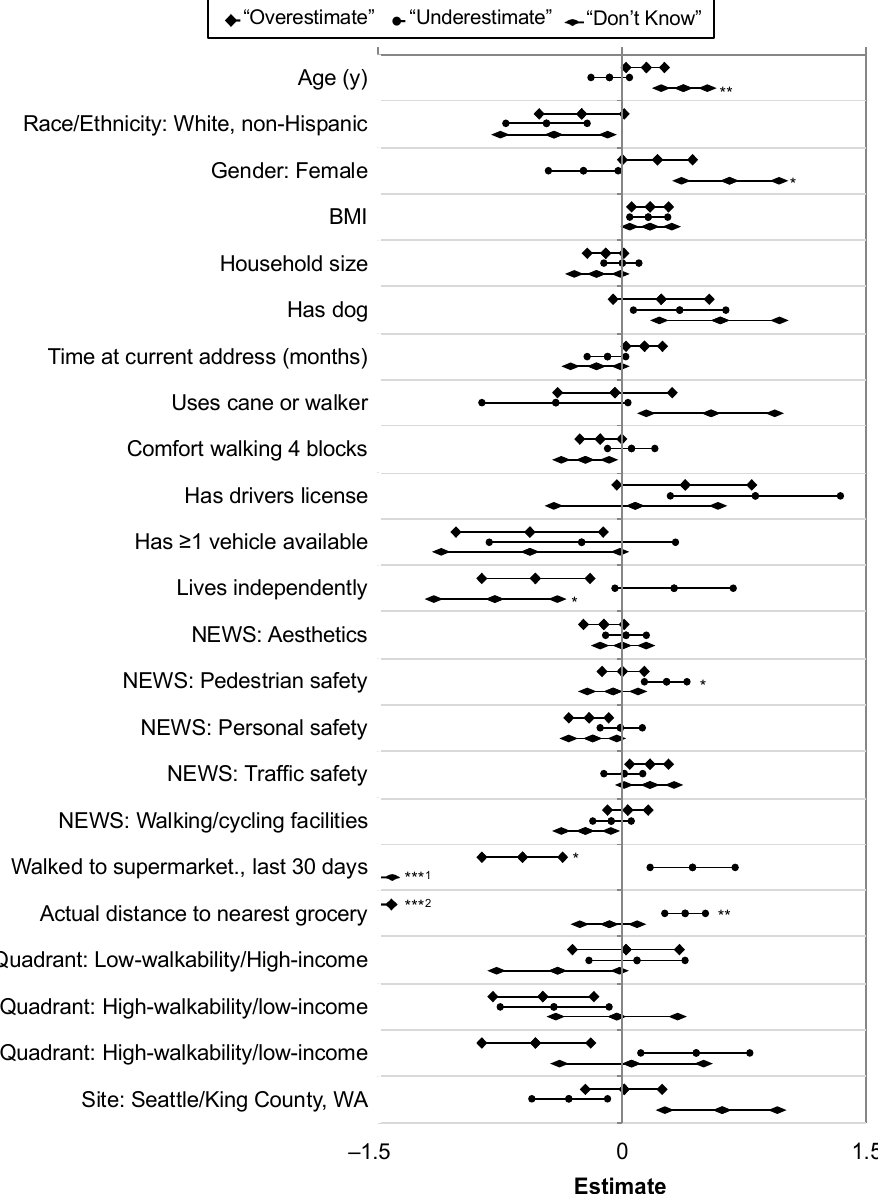
Figure 4. Multinomial log-linear model results: Predictor coefficient estimates and standard errors for overestimators, underestimators, and individuals reporting “Don’t Know” for perceived walking distance to the closest grocery store, compared to individuals with accurate perceptions. Note: Significance levels (determined by z-test) indicated by: *** p < 0.001; ** p < 0.01; * p < 0.05. 1 Actual coefficient estimate not shown: −15.48 (standard error< 0.001). 2 Actual coefficient estimate not shown: −1.92 (standard error = 0.18).